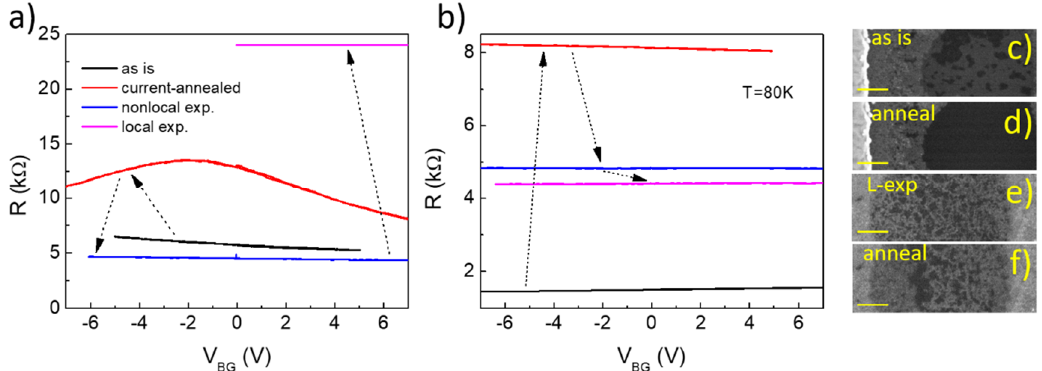
Figure 3. ( a ) Gating curves of a suspended graphene channel during various e-beam exposure steps. ( b ) Gating curves after various Joule-heating annealing attempts. The curves were measured at a sample temperature of 80 K. ( c – f ) Secondary electron images of a graphene channel at various sequential stages of e-beam exposure treatments. Scale bar in Figure 3c–f: 100 nm.